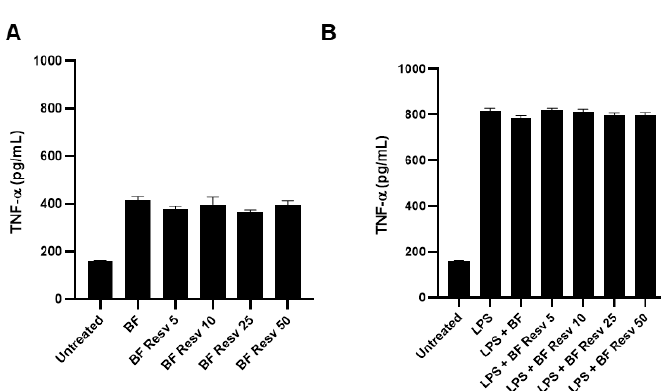
untreated (black filled circle) or incubated with 30 µM (gray-filled square) Resveratrol in MRS medium at 37 °C. The OD 600 was monitored at 1 h intervals for 23 h. Values represent mean ± SEM of three separate experiments.